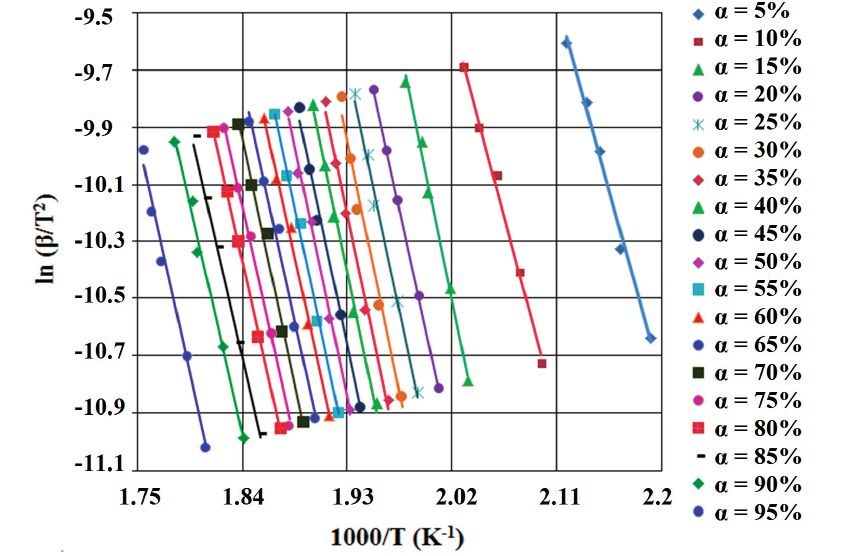
Figure 8. KAS (Kissinger-Akahira-Sunose) diagram, for SB1 derivative.